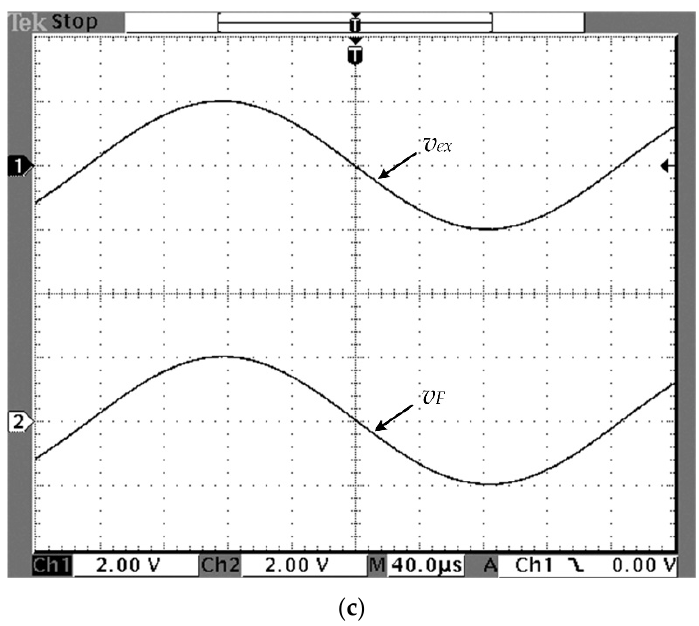
Figure 9. Percentage errors of resolver signals with temperature compensation using the proposed technique: ( a ) voltage signal v RC ; ( b ) resolver signal v S 1 ; ( c ) waveform of signals v ex and v F .